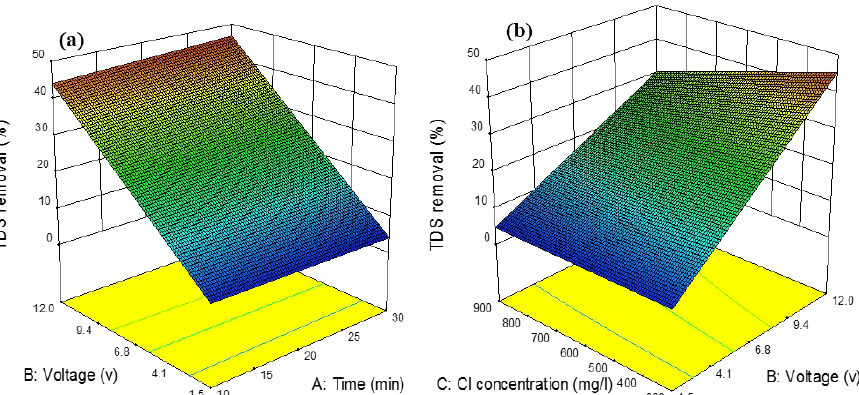
Fig. 5. 3-D Plots for effects of a) consumption voltage and process runtime (Cl − ion initial concentration: 300 ppm) and b) consumption voltage and Cl − ion initial concentration (process runtime: 30 minutes) on TDS removal